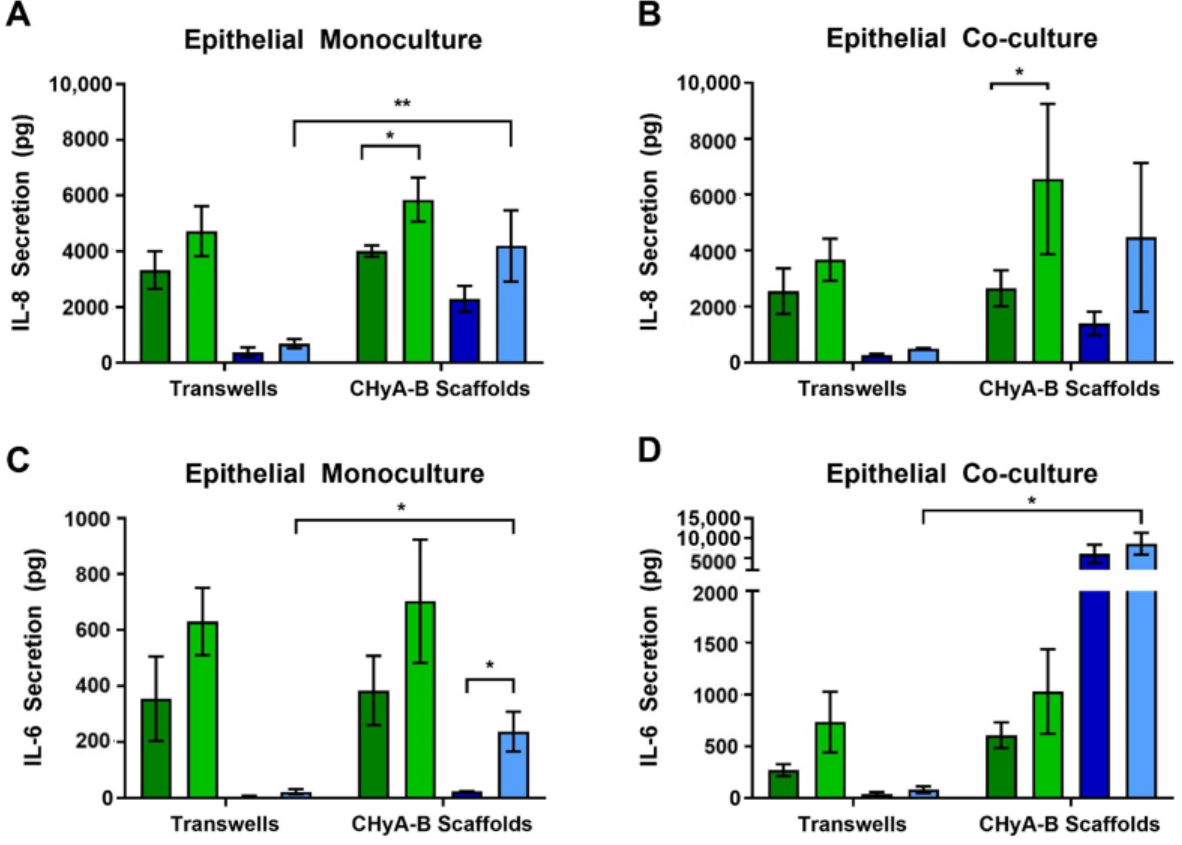
Figure 3. Pro-inflammatory cytokine release profile from epithelial cultures following LPS exposure. Apical and basolateral IL-8 release from Calu-3 monocultures ( A ) and Calu-3 Wi38 co-cultures ( B ) on Transwell ® inserts and CHyA-B scaffolds following LPS exposure with 10 µ g/mL of P. aeruginosa derived LPS for 24 h. Apical and basolateral IL-6 release from Calu-3 epithelial monocultures ( C ) and Calu-3 Wi38 co-cultures ( D ) on Transwell ® inserts and CHyA-B scaffolds following LPS exposure. Results displayed as mean ± SEM ( n = 3; * p < 0.05, ** p <